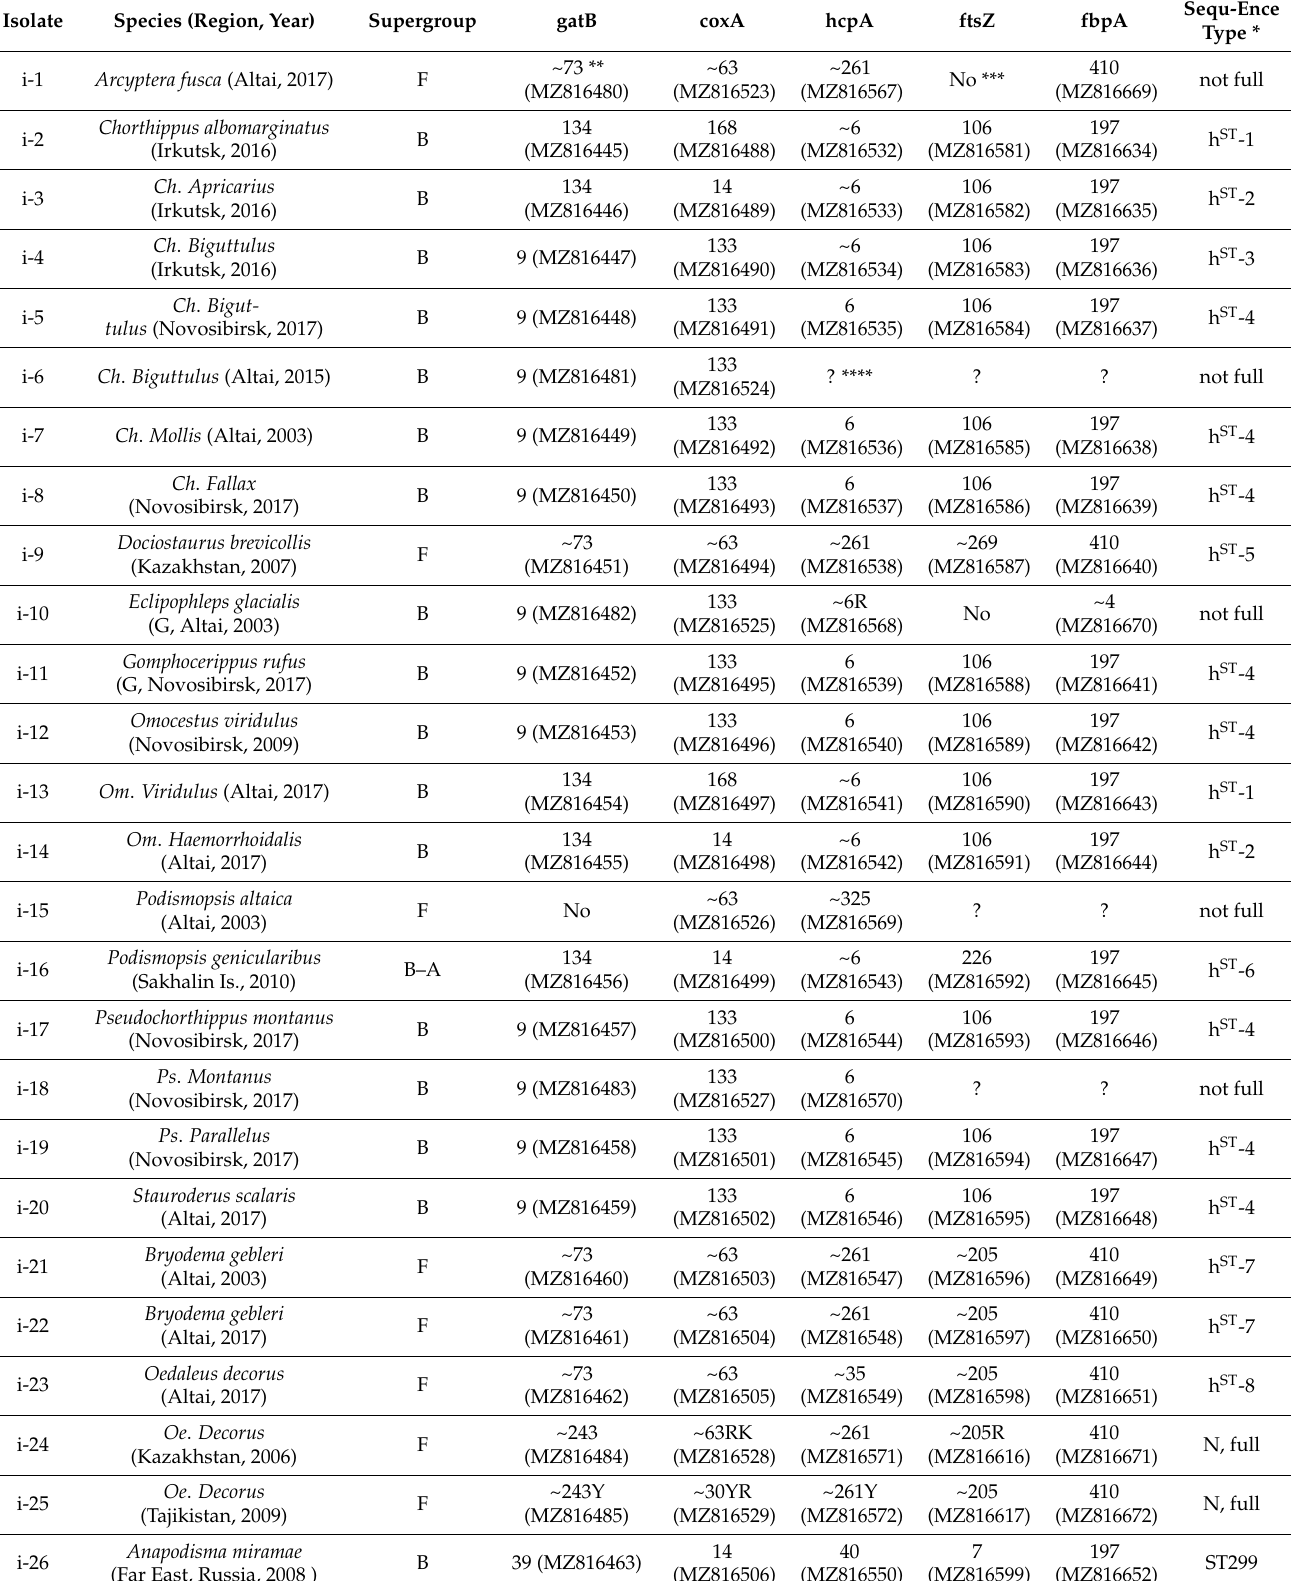
Table 2. Wolbachia MLST profiles of the analysed Acrididae